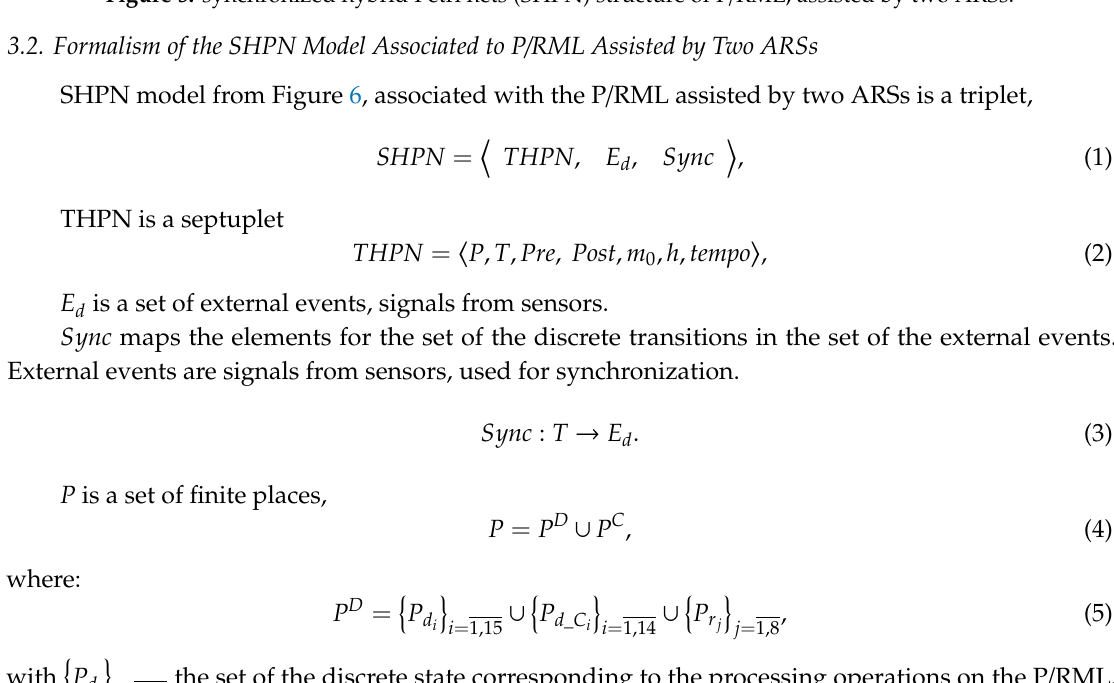
/ RML, assisted by two